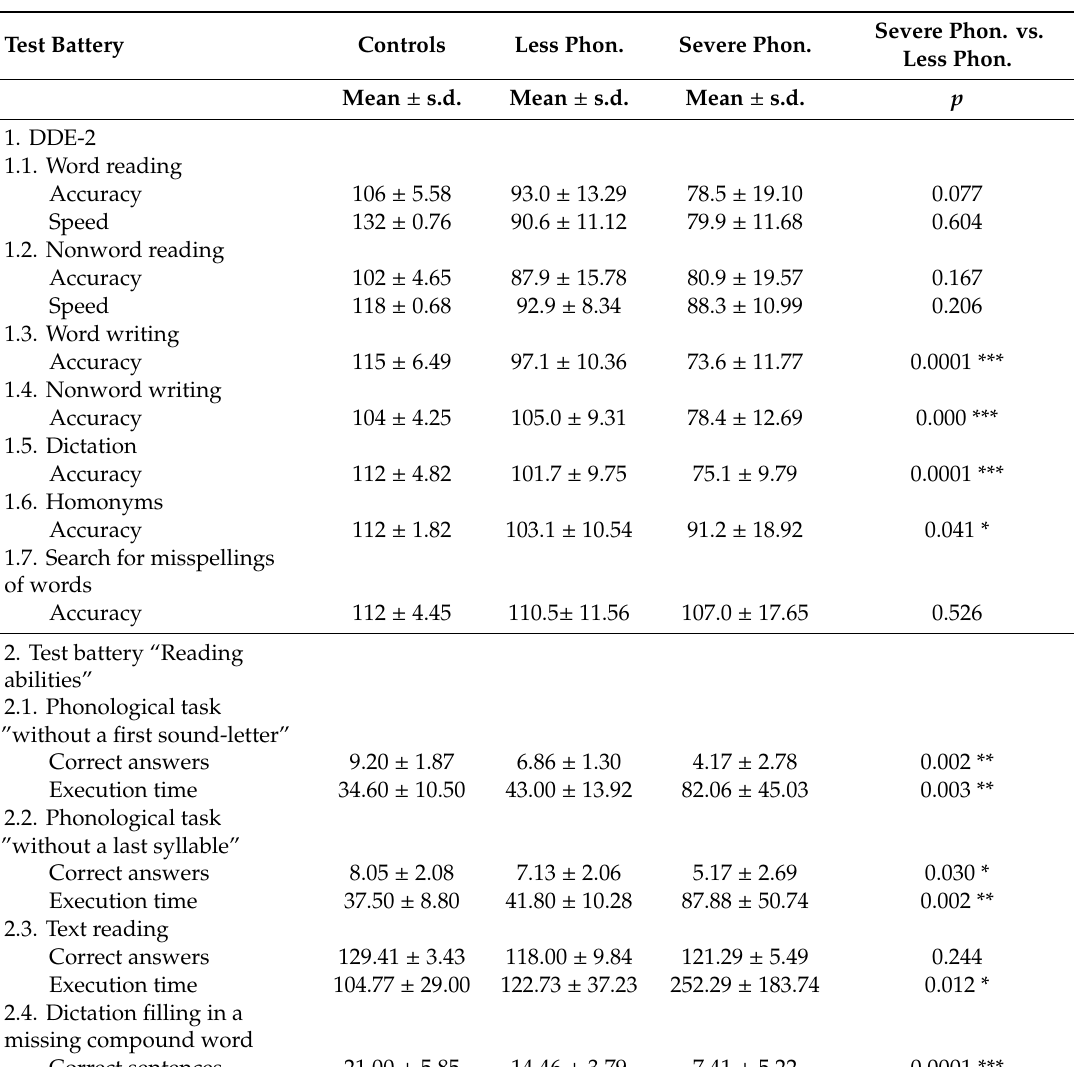
Table 1. The group data of the test battery DDE-2 and test battery “Reading abilities” in standard scores. Test